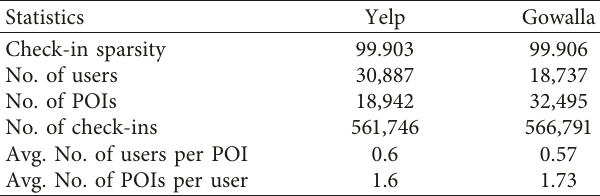
Table 1: Statistics of the training data of Gowalla and